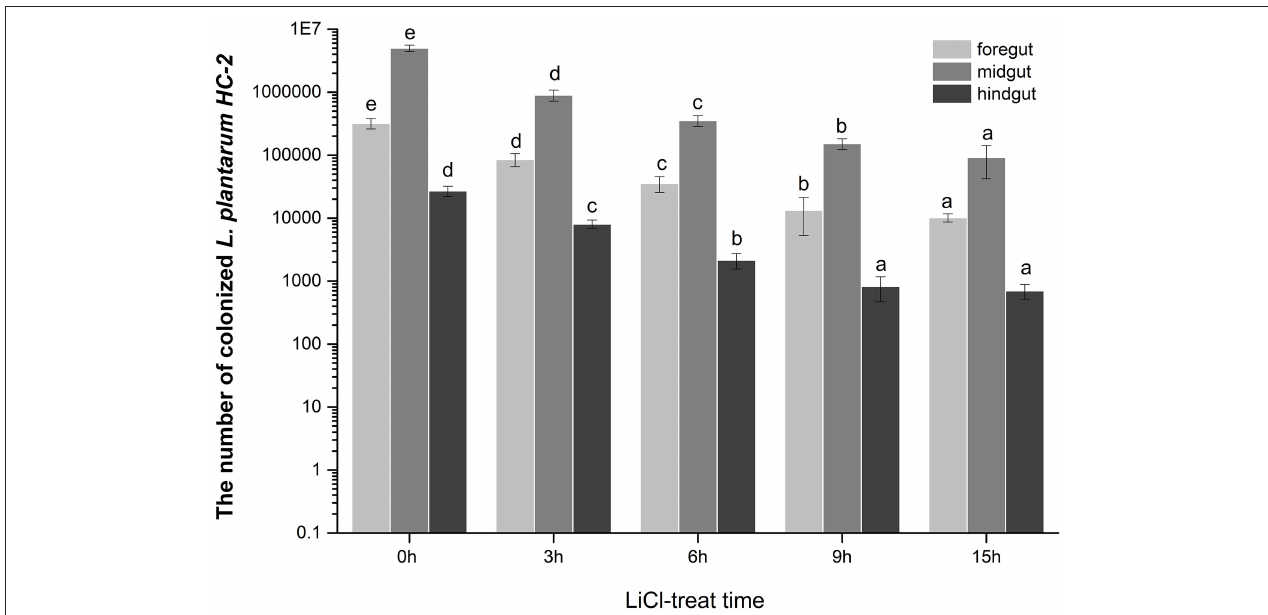
FIGURE 7 | The numbers of the L. plantarum HC-2 colonization in the foregut, the midgut, and the hindgut of the shrimp. The bacteria were added to the basal diet (5 × 10 8 CFU/g feed) and the shrimps were fed continuously for 2 weeks, and the intestine of the shrimp, after one day of starvation was sampled. The intestinal contents were washed with sterile PBS, and then bacterial DNA was extracted from the foregut, midgut, and hindgut respectively, and the number of bacteria was detected by real-time quantitative PCR using a specific primer. Values were means ± SE, and different letters denote significant differences among different groups ( p < 0.05).